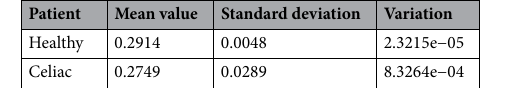
Table 6. Interpretation of the average variation of green